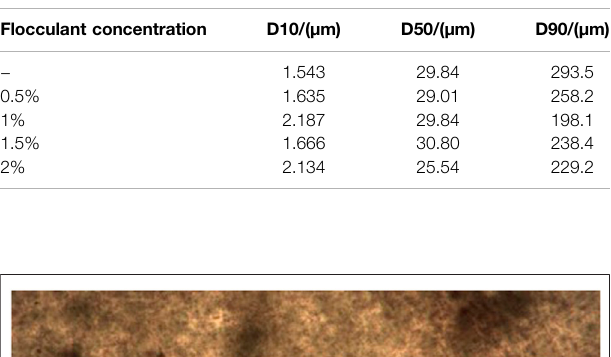
TABLE 6 | Effect of CaCl 2 with different concentrations on Zeta potential of PEM drilling fl uid. Flocculant concentration